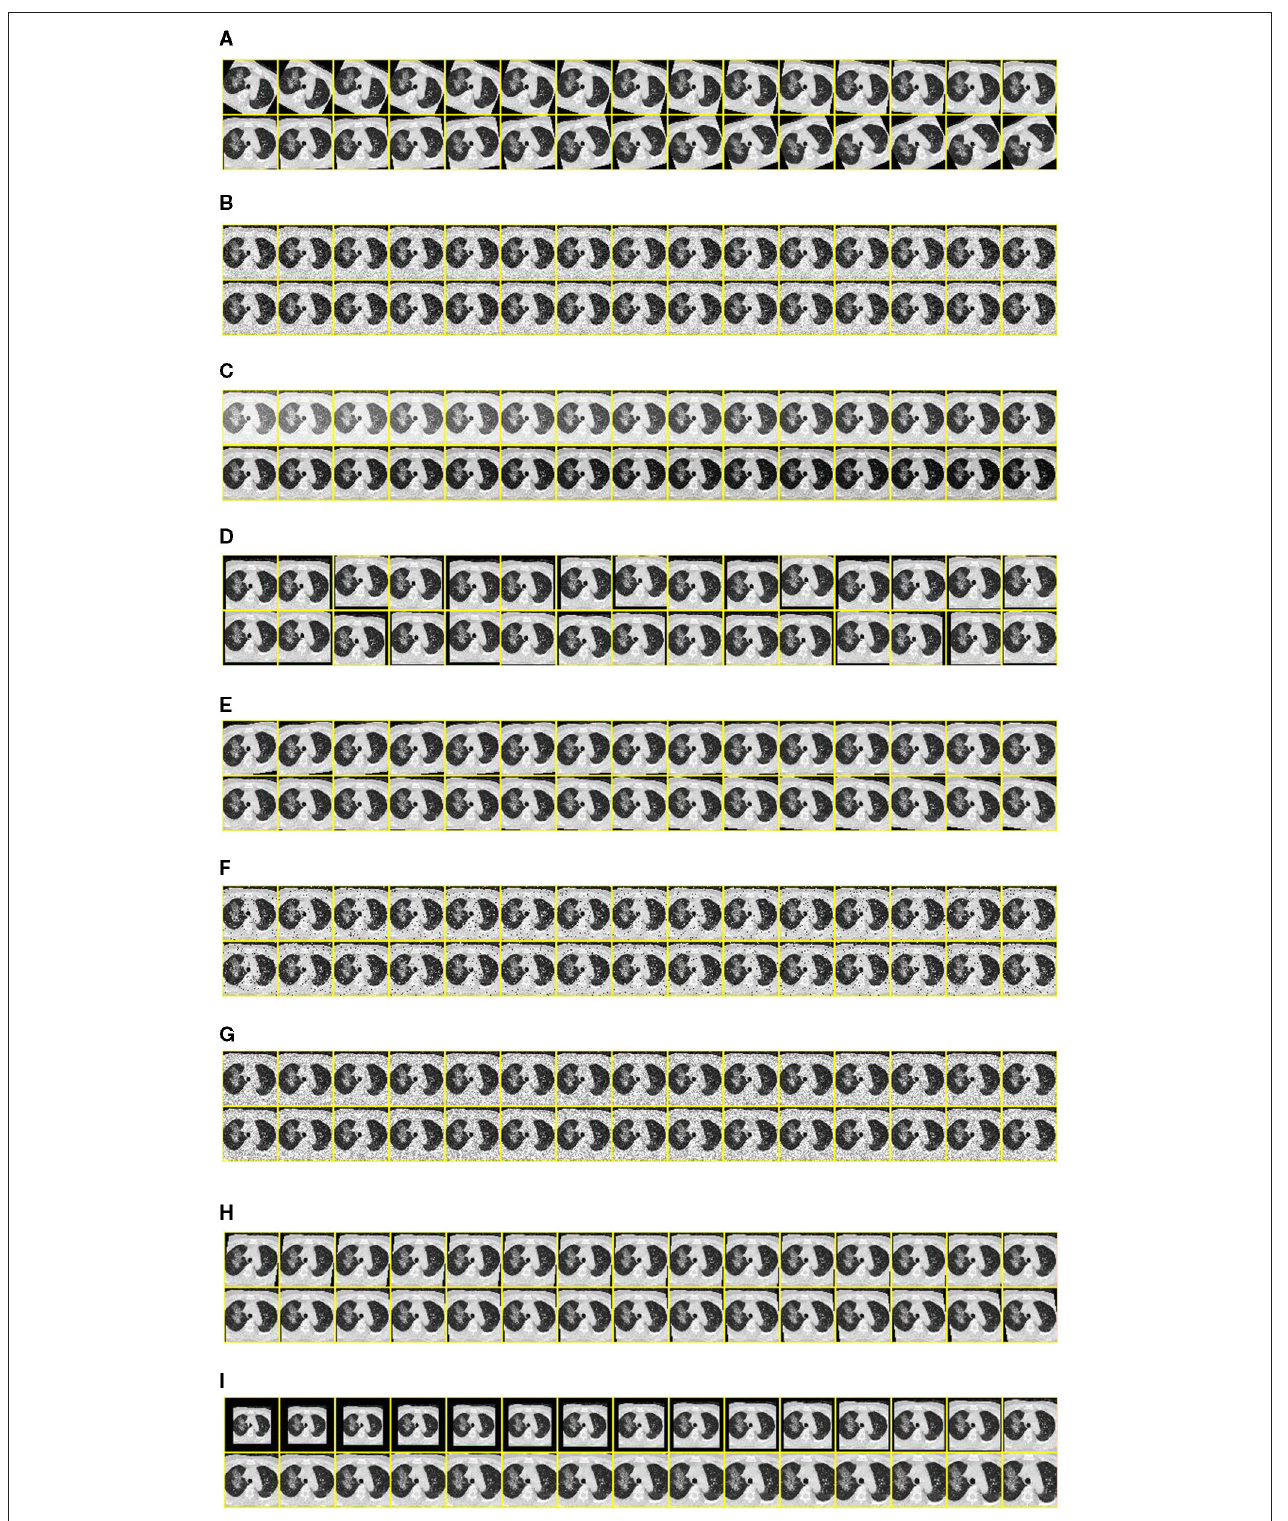
FIGURE 9 | 18-way DA results. (A) Image rotation, (B) Gaussian noise, (C) gamma correction, (D) random translation, (E) vertical shear, (F) salt-and-pepper noise, (G) speckle noise, (H) horizontal shear, and (I) Scaling.